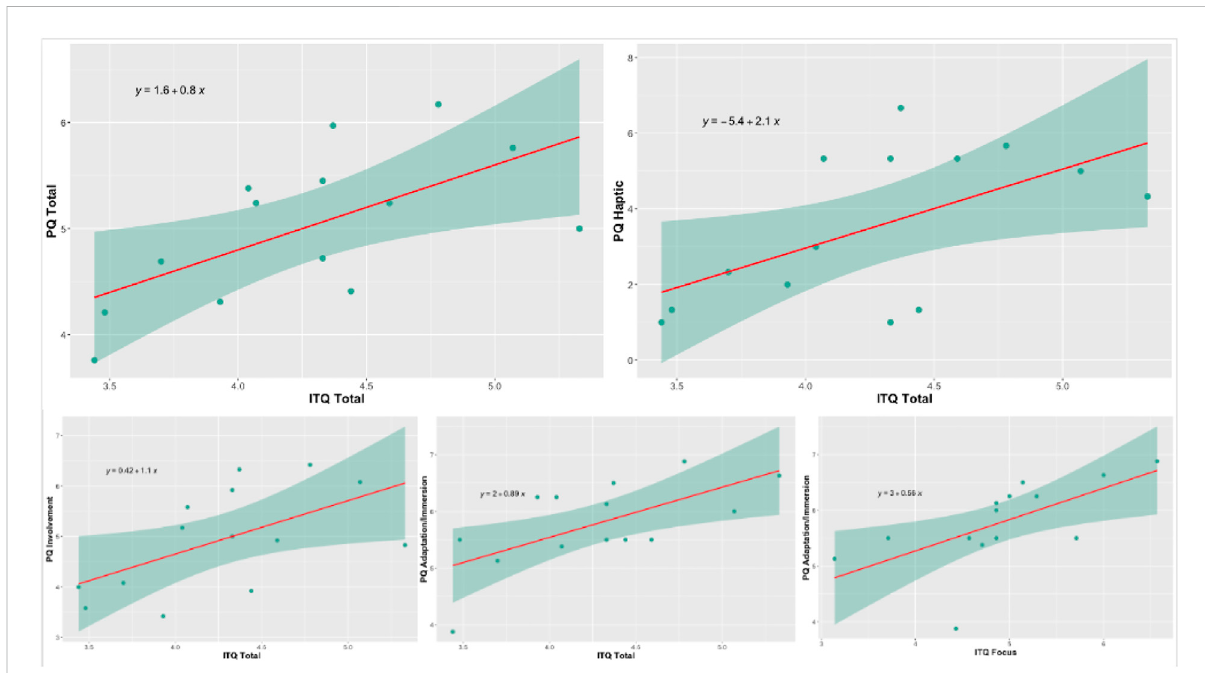
FIGURE 8 Scattergrams for Left to right, top: ITQ-PQ, ITQ-PQ Haptic; bottom: ITQ-PQ Involvement, ITQ-PQ Adaptation/Immersion, ITQ Focus-PQ